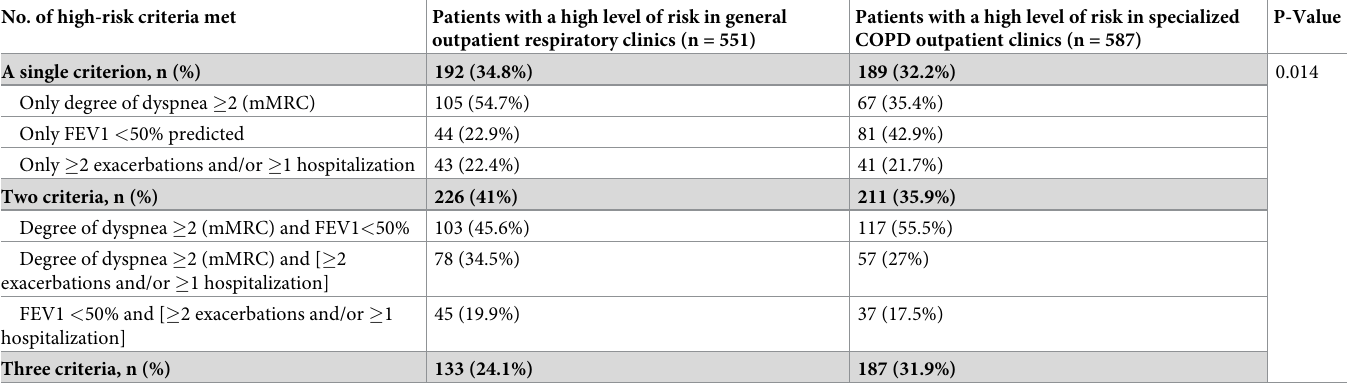
Table 3. Distribution of high-risk patients according to criteria that define their high-risk level at both clinic models. No. of high-risk criteria met Patients with a high level of risk in general Patients with a high level of risk in specialized outpatient respiratory clinics (n = 551) COPD outpatient clinics (n = 587)